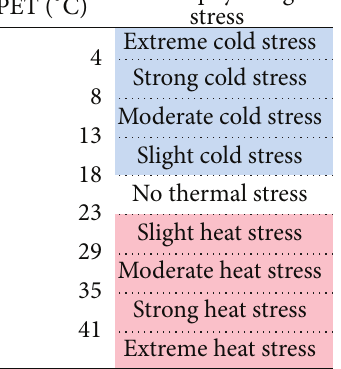
Figure 2: PET range with corresponding grade of physiological stress for humans [20]. Blue represents cold stress classes, white represents no thermal stress, and red represents heat stress